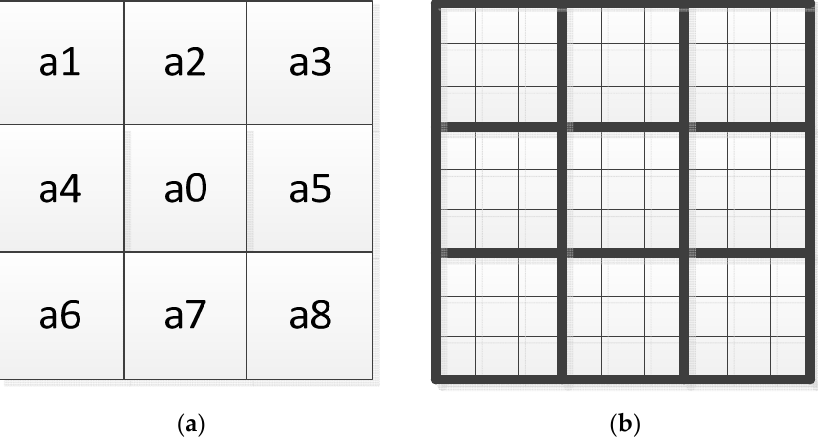
Figure 2. ( a ) The basic 3 × 3 operator of the LBP algorithm; and ( b ) multi-scale LBP (Local Binary Pattern) based on blocks of 9 × 9 size. Computation is done based on average values of block sub regions, instead of individual pixels. In each sub-region, average sum of image intensity is computed. These average sums are then compared with the gray value of the center block.